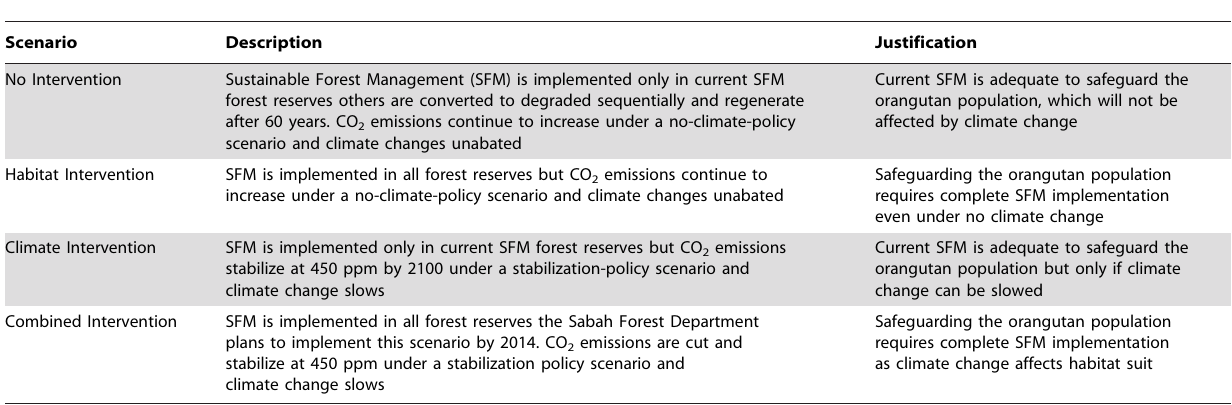
Table 2. Future land-cover and climate change scenarios evaluated for their effect on orangutan spatial abundance in Sabah.